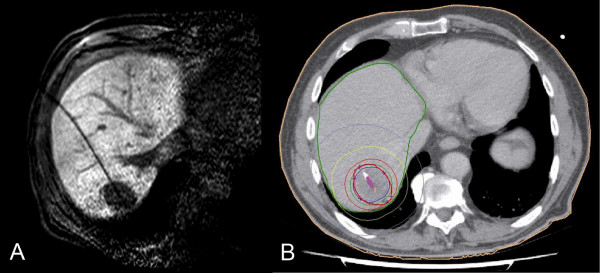
Illustration of MR-guided HDR-BT and 3D dosimetry. 77-year-old man with colorectal liver metastasis in segment VII scheduled for high-dose-rate brachytherapy (HDR-BT). The implantation of one brachytherapy catheter was performed under MRI guidance (A). The tumor enclosing dose (D100) was 21.8 Gy (B).